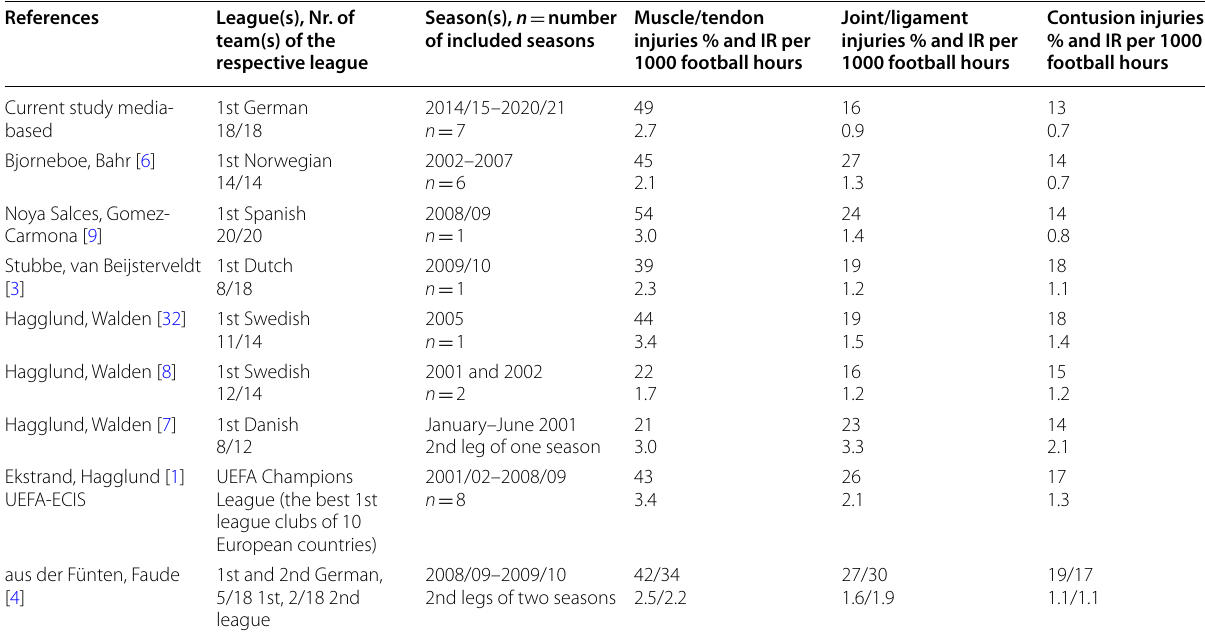
Table 6 (Inter)national comparison of injury type